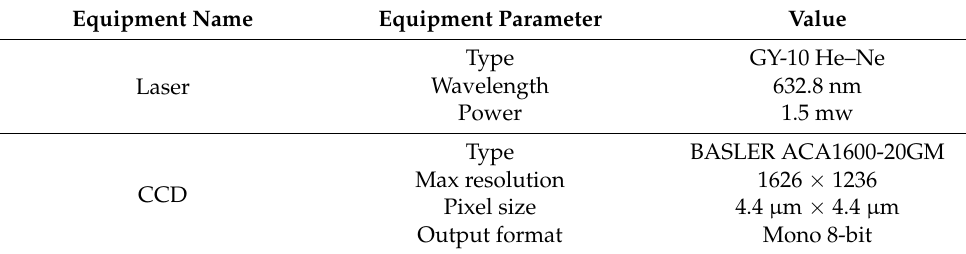
Figure 10. Laser spot images are collected by CCD: ( a ) experimental platform; ( b ) continuous image acquisition. Table 1. Device parameters used for the experiment.